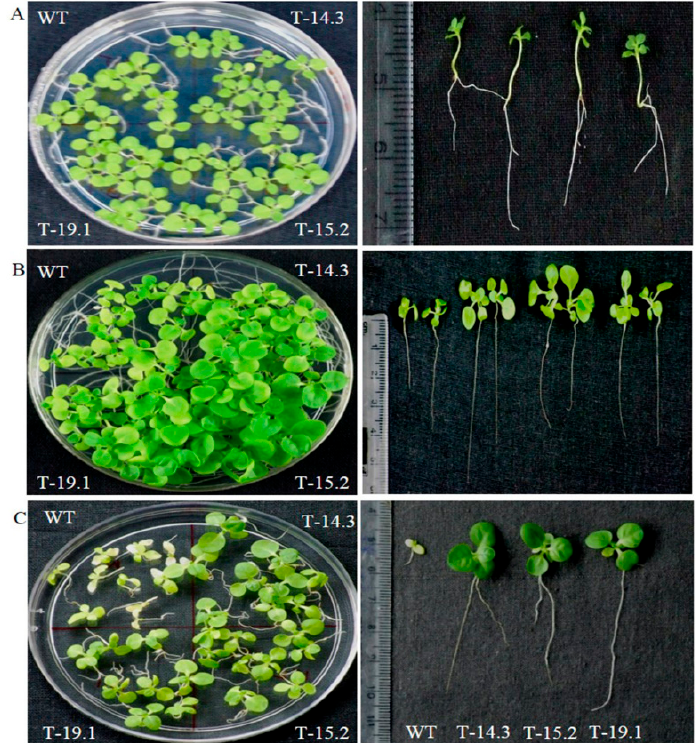
Figure 12. Seedling growth under salt stress. ( A ) Seedlings after 18 days of transfer on half strength MS medium; ( B ) seedlings of WT and AnnAt8 transgenic lines after 56 days of growth on 100 mM NaCl; ( C ) seedlings of WT and transgenic lines after 42 days of growth on 200 mM NaCl. Three replicates were used per treatment and the experiment repeated three times.